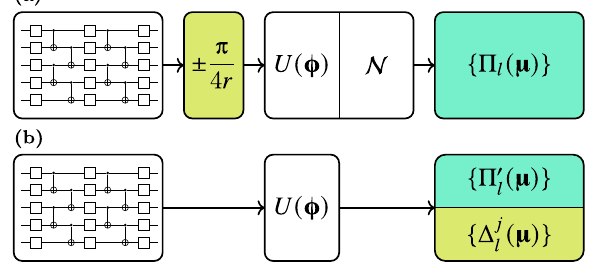
Fig. 3 Average phase sensing results. Semi-logarithmic plot of the Cramér-Rao bound for average phase sensing over the dephasing probability of (blue) the standard Ramsey probe and (orange) a GHZ probe. Each green dot marks the bound for a probe optimized for the particular dephasing probability. The phase shifts were fi xed at . We recover the the optimal spot for GHZ sensing at ϕ j ¼ π 6 optimality of the GHZ probe in the noiseless case and fi nd improved sensing protocols in the noisy